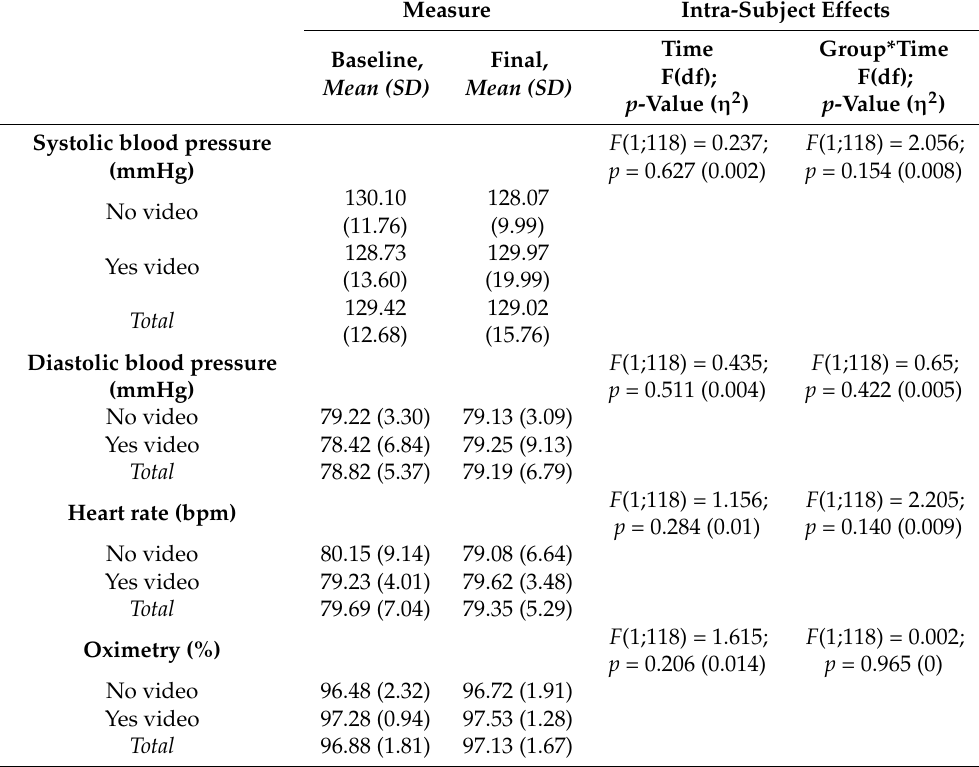
Table 4. Means (SD) and statistical contrasts between groups of the hemodynamic